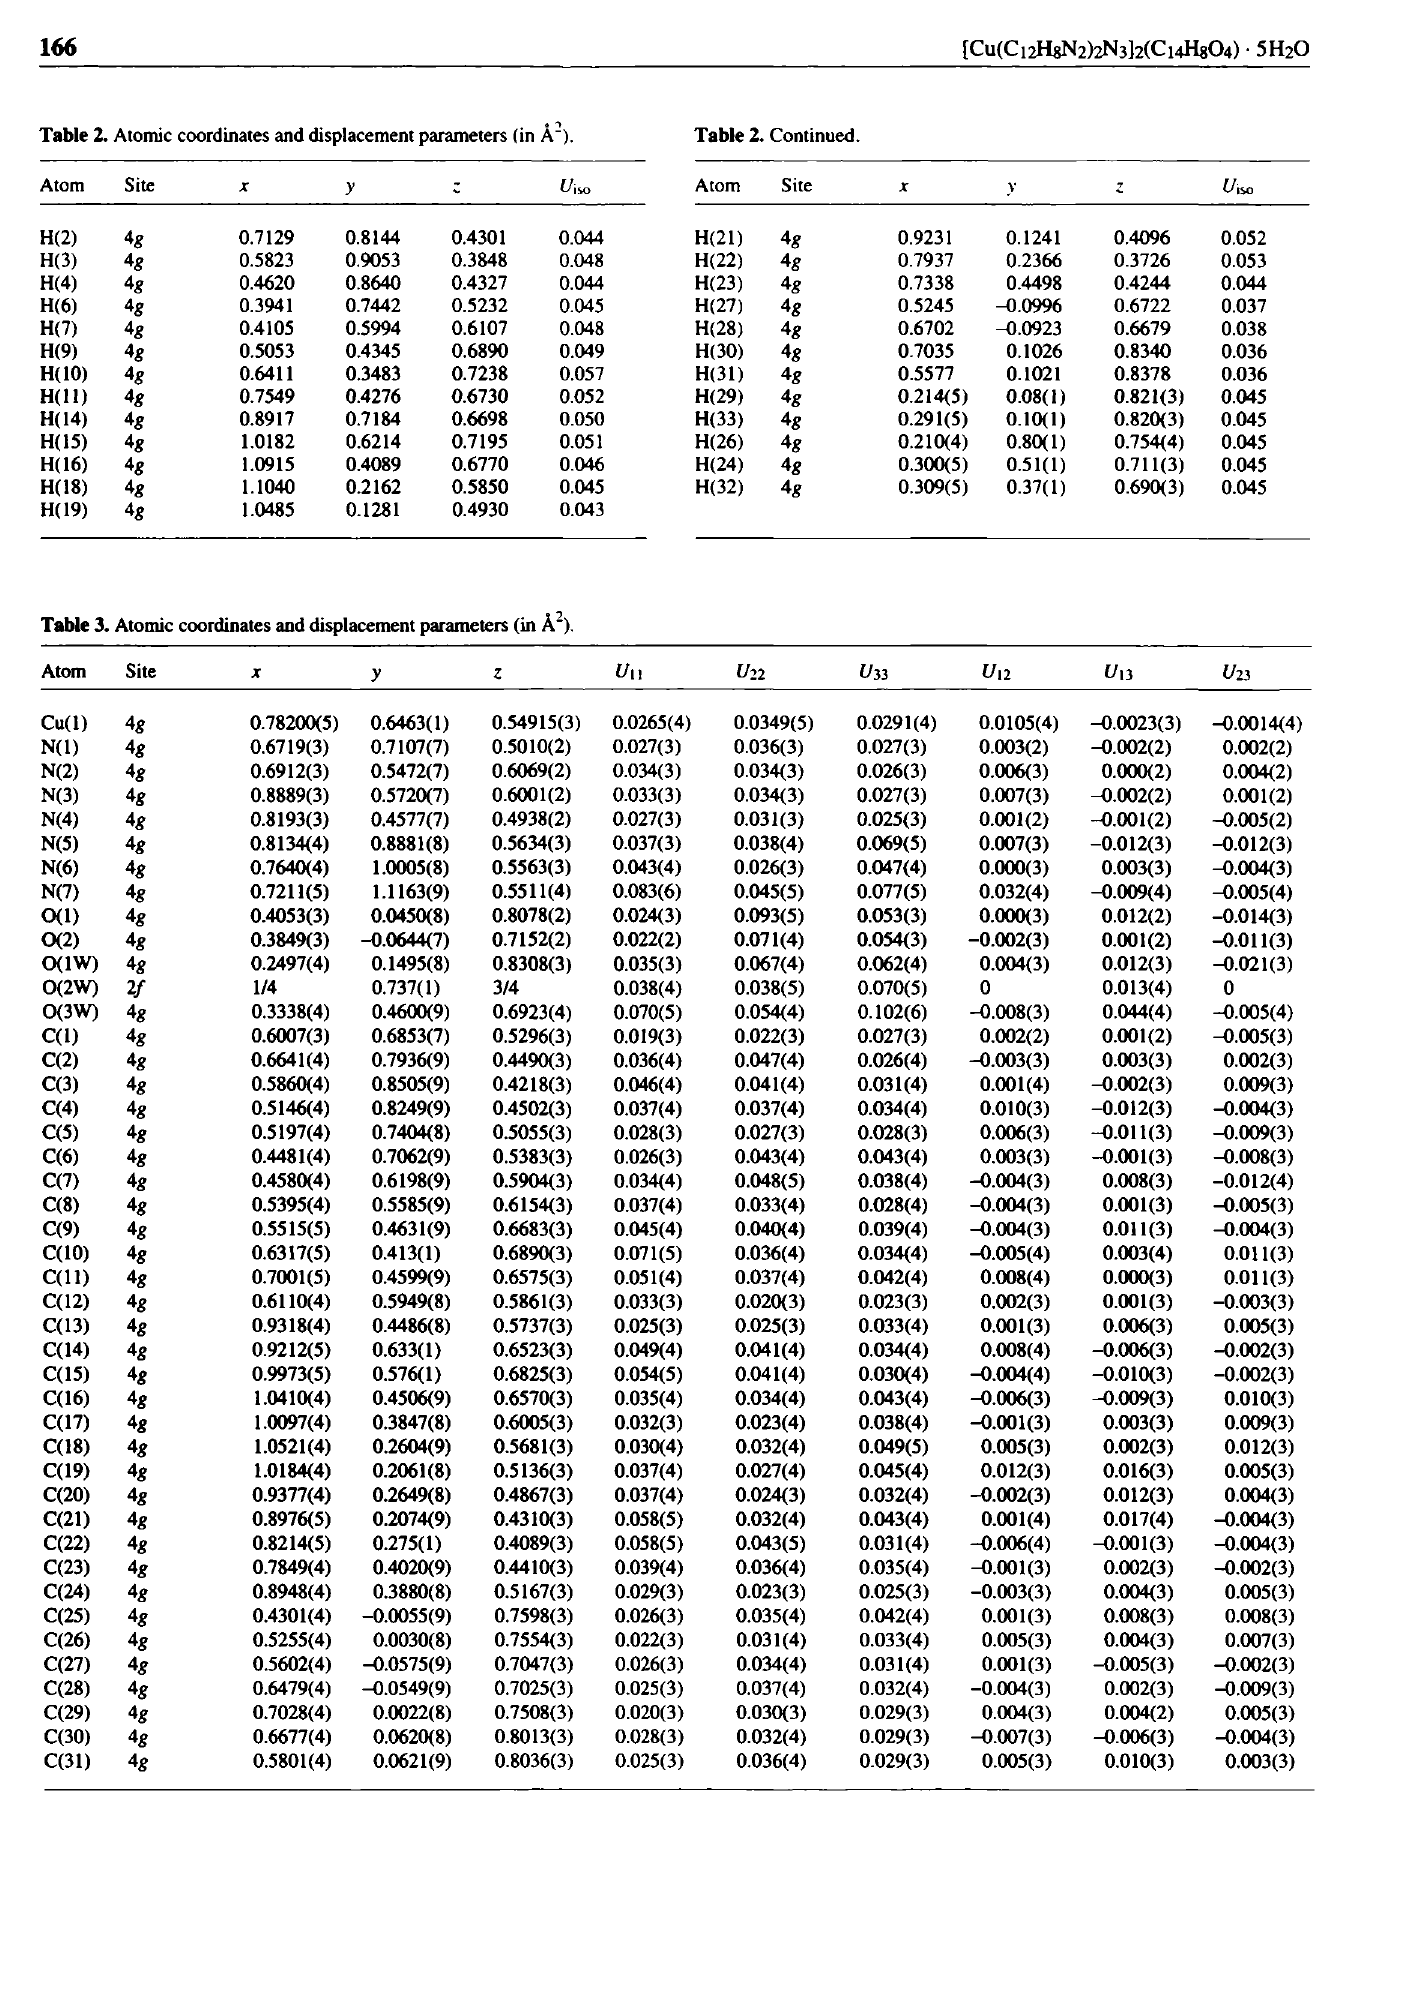
Table 2. Atomic coordinates and displacement parameters (in À").